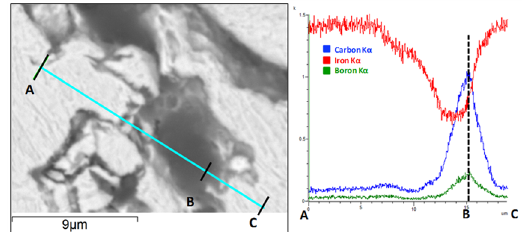
Figure 8. Semi-quantitative compositional analysis via EDS line scan confirming carbon and boron in the dark precipitates from Figure 7.